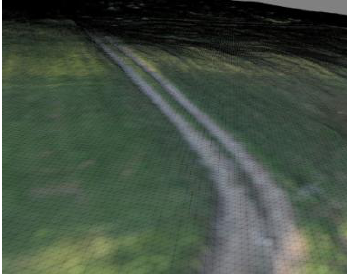
Figure 5. Detailed view of coloured DTM with 0.20 m